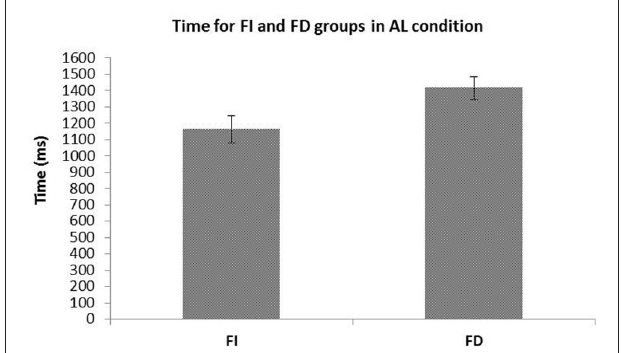
FIGURE 3 | Mean and S.E.M. of time by Field Independent (FI) and Field Dependent (FD) groups to perform the recognition task with all landmarks available. The FI group was faster than the FD one.